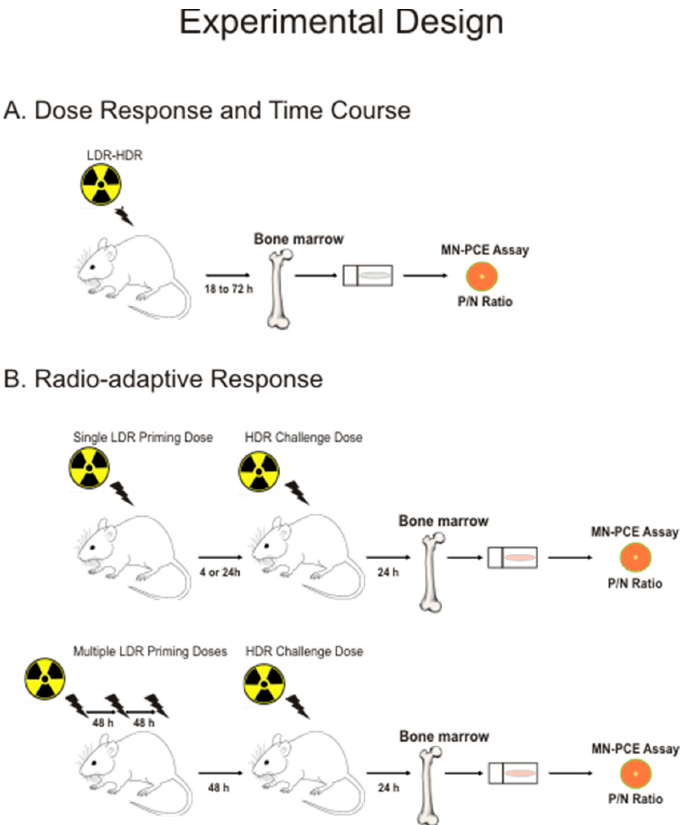
Figure 1. Overview of experimental design. Bone marrow cells were harvested from femora of C57BL/6 or BALB/c mice following total body in vivo LDR (low-dose radiation) or HDR (high-dose radiation) exposures to 60 Co γ radiation. ( A ) For dose–response and time-course experiments, single acute doses of radiation (20 mGy to 2 Gy) were delivered to mice, and mice were euthanized 18 to 72 h post-irradiation; ( B ) For radio-adaptive response experiments, LDR was delivered as a single 20 mGy or 100 mGy priming dose ( B , upper panel ) or multiple 20 mGy priming doses ( B , lower panel ) at time intervals spanning four hours to six days prior to a subsequent HDR challenge dose, and mice were euthanized 24 h following the challenge irradiation. The induction of micronuclei in polychromatic erythrocytes (MN-PCE) frequency was measured in isolated bone marrow erythrocytes and the ratio of polychromatic: normochromatic erythrocytes ( P / N ratio) was determined.